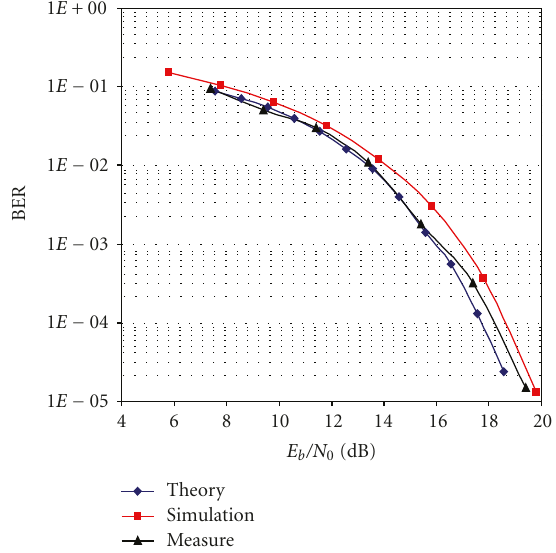
Figure 6: 802.11g AWGN compared results.